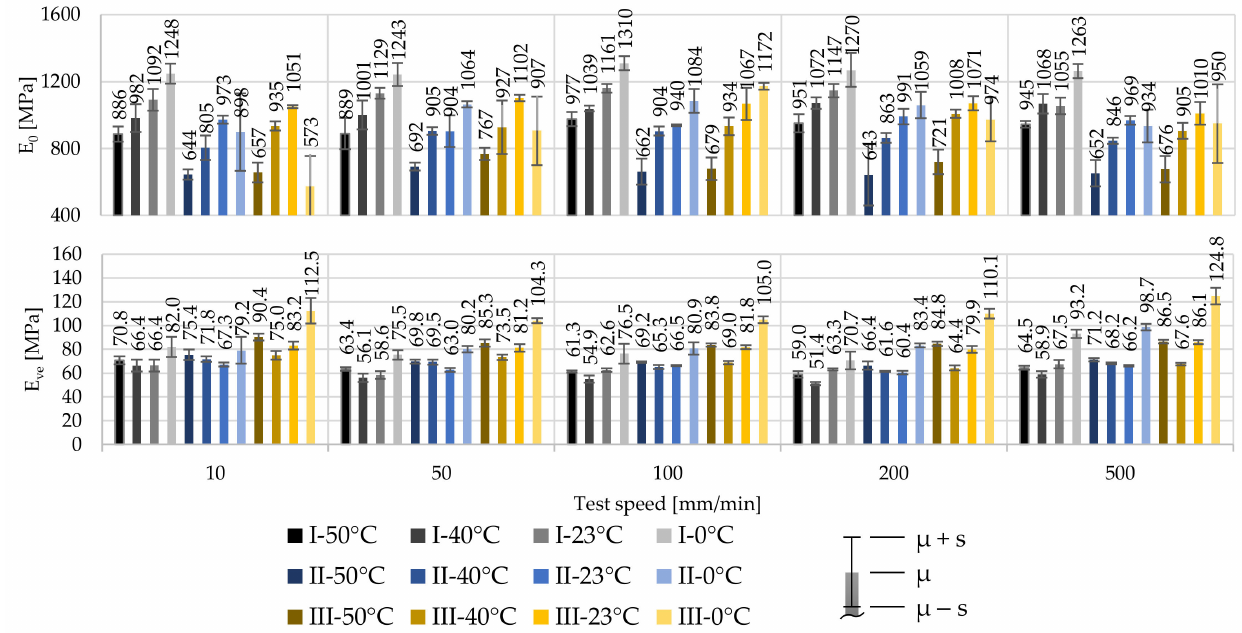
Figure 6. Influence of the test temperature and test speed on E 0 and E ve for 250 µ m ETFE foils of producers I, II, and